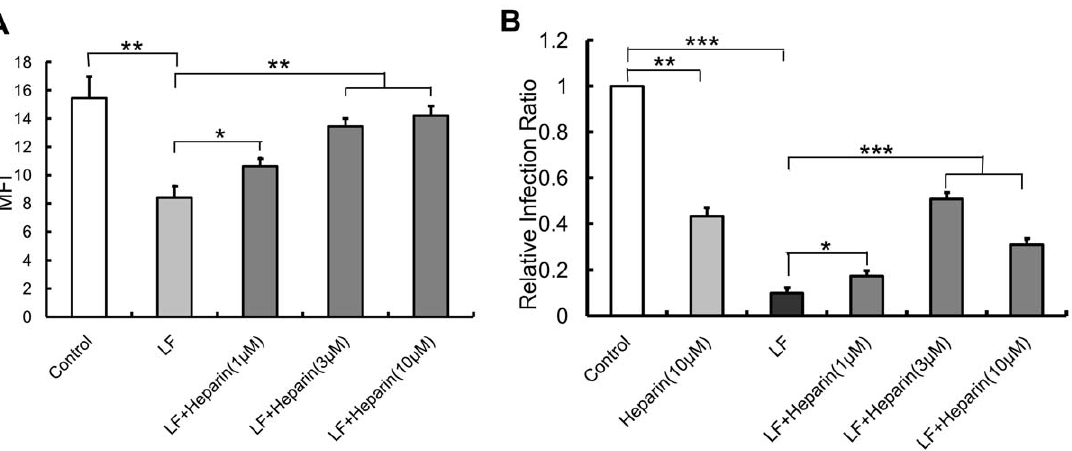
Figure 4. Lactoferrin exerts its inhibitory effect on spike protein and SARS pseudovirus by binding to cell-surface HSPGs. ( A ) Heparin neutralizes the LF-mediated inhibition of S1190-Fc binding to HEK293E/ACE2-Myc cells. Before treatment with 10 m M LF for 1 h at 37 u C, HEK293E/ ACE2-Myc cells were incubated with heparin for 10 min at the concentration of 1 m M, 3 m M or 10 m M. S1190-Fc was added to each group to detect S1190-Fc binding to the cells as described above. Error bars represent the SD of three independent experiments. ***P , 0.001, **P , 0.01 and *P , 0.05. ( B ) Inhibition of SARS pseudovirus infection of HEK293E/ACE2-Myc cells by LF can be partially neutralized by heparin. HEK293E/ACE2-Myc cells were treated with heparin for 10 min at the concentration of 1 m M, 3 m M or 10 m M. Then, 10 m M LF was added to each group and incubated at 37 u C for 1 h. The GFP-expressing HEK293E/ACE2-Myc cells in the total population were analyzed as described above. The relative viral infection ratio was measured by comparing the percentage of GFP expressing cells of each group with that of the BSA control. Error bars represent the SD of three